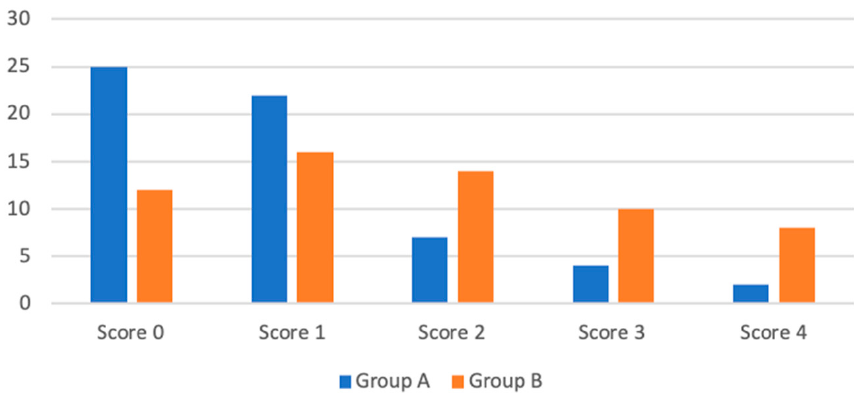
Figure 2. Oblique and horizontal layering technique scoring distribution.